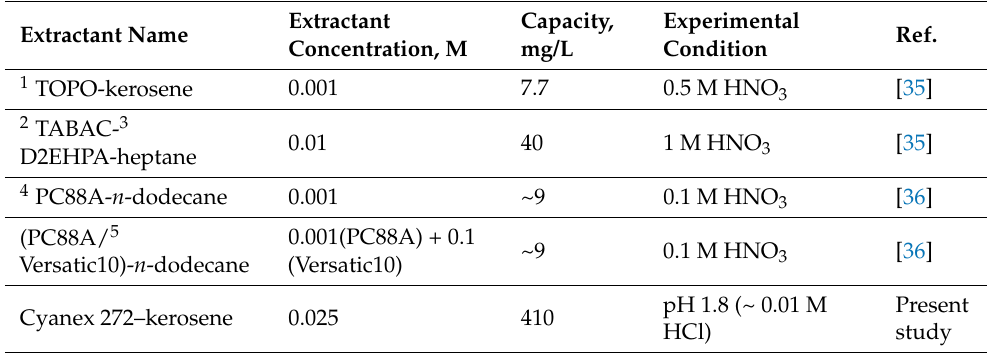
Table 2. Comparison of the capacity of different extractants with Cyanex 272 for the extraction of